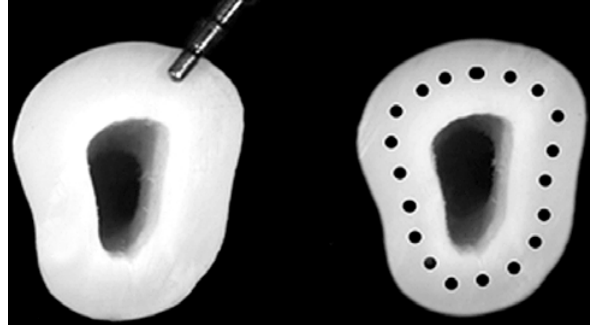
FIGURE 1- Reference points located around the cervical portion of the